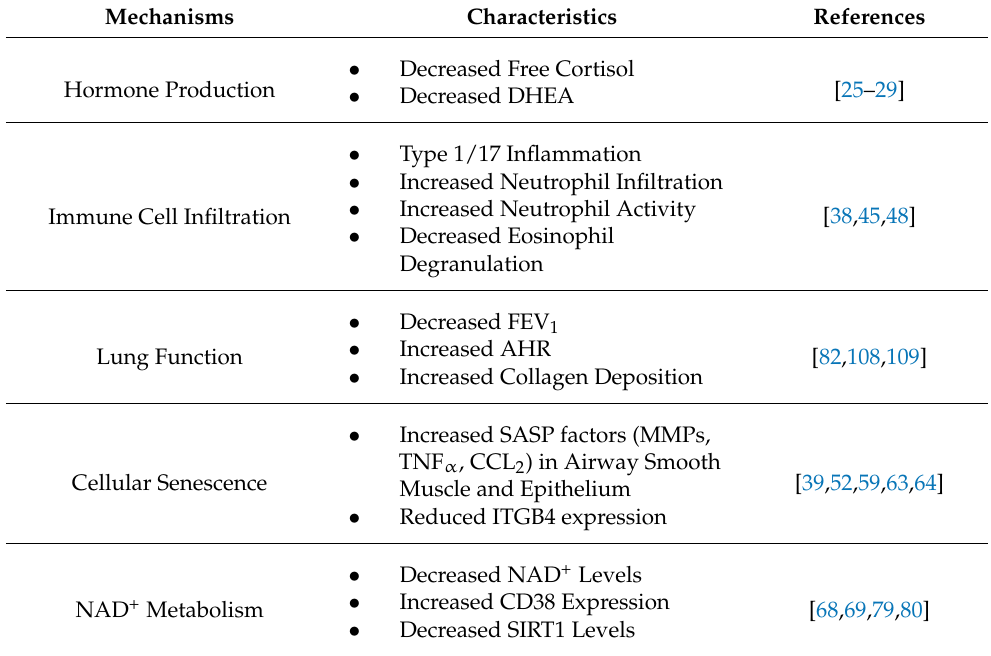
Table 1. Mechanisms of Asthma in the